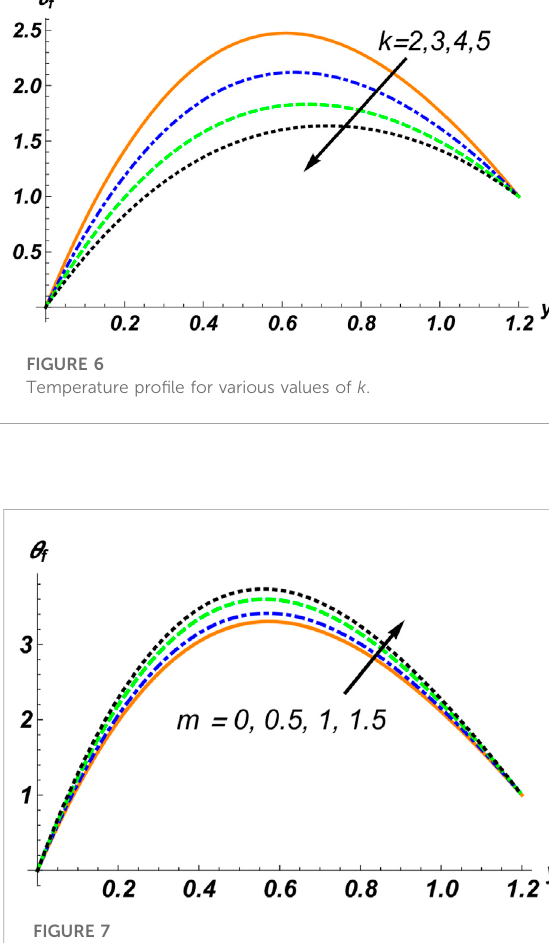
Temperature pro fi le for various values of m